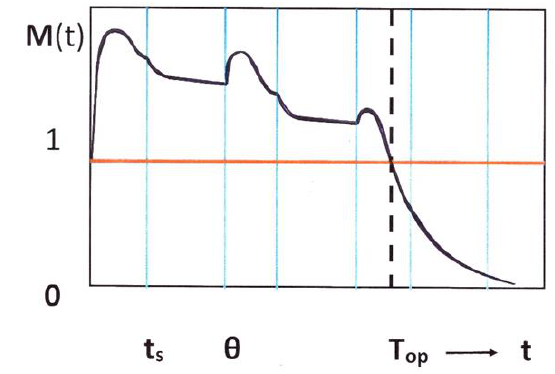
Fig. 16. The relative nuclear magnetization of molecular hydrogen diluted in a magnetic viscous organic solution departs from its equilibrium value (M=0) reached for times much longer than the conversion time T op . t s represents a sticking time and θ the interval between two